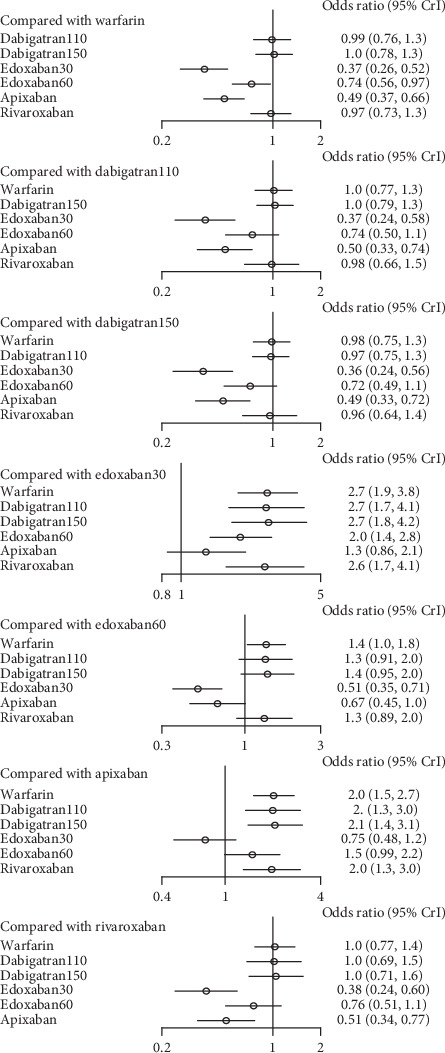
Forest plot for the safety of the comparison among different treatments of patients with moderate renal function.